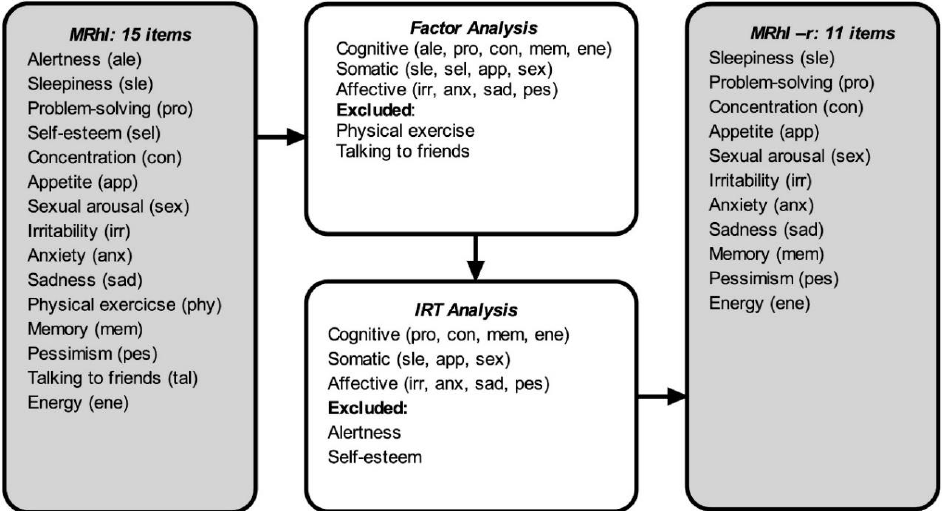
Figure 1. Flowchart showing the various steps in the development of the revised mood rhythm instrument (MRhI-r). Table 3. Item difficulty, fit measures, and differential item functioning of subscales (MRhI—11 items). Table 2. Item difficulty, fit measures, and differential item functioning of subscales (MRhI—13 items).